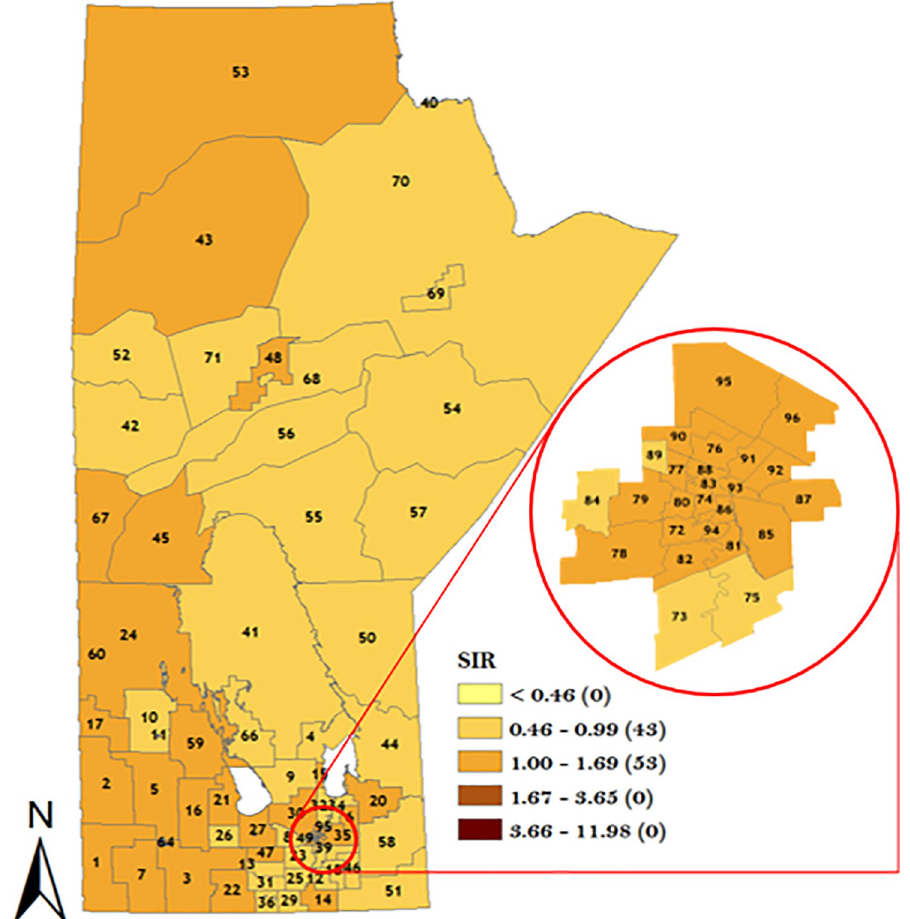
Fig 9. Map of standardized IRR of overall CGC in Manitoba using Poisson regression model. Numbers in the map are the district labels from 1 to 96. Number of districts in each risk category is shown in parenthesis in the legends.